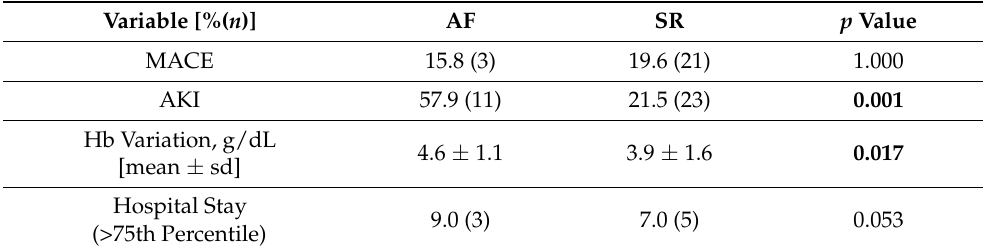
Table 3. Postoperative outcomes at 30 days of follow-up.